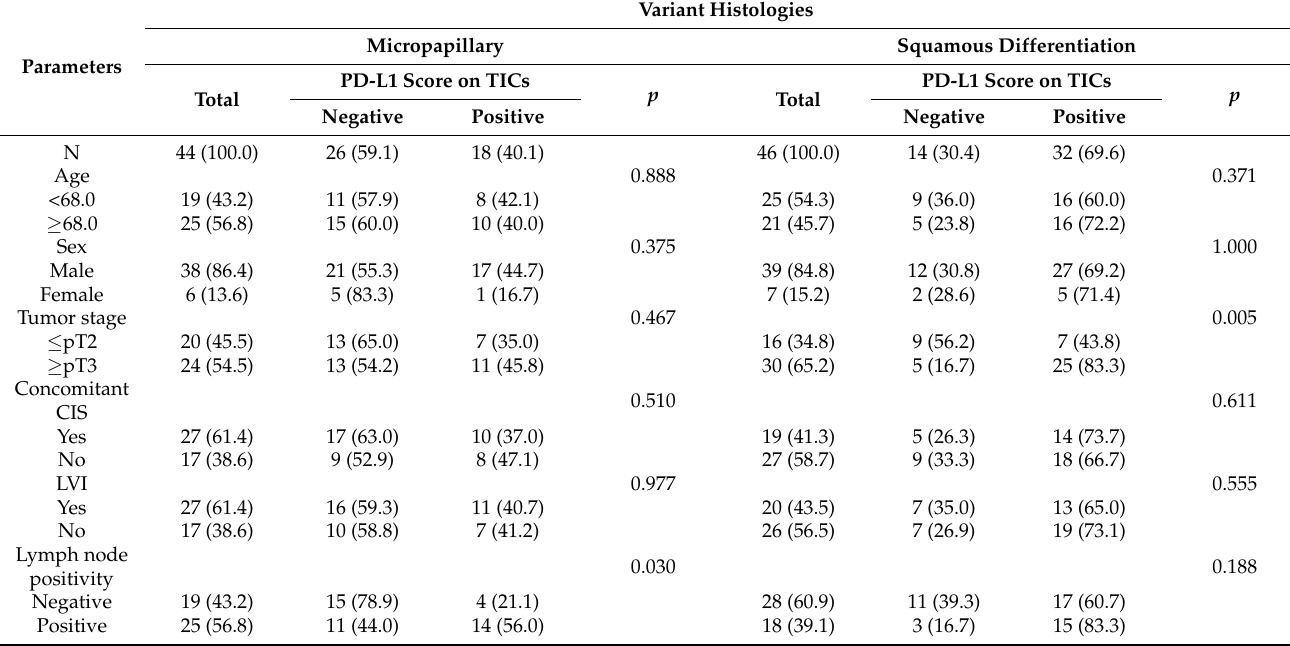
Table 2. Association of PD-L1 expression and clinicopathologic characteristics.